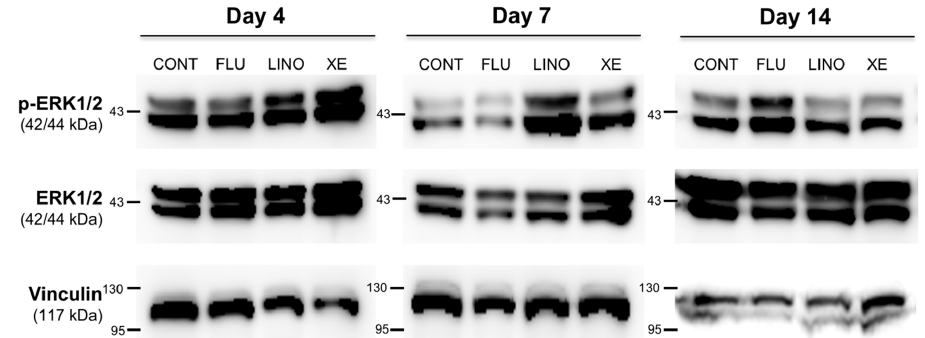
Figure 9. Alterations of ERK1/2 phosphorylation by the K V 7 opener or K V 7.3 blockers in MG-63 cells. Western blot analysis showed that, while linopirdine (30 µ M) and XE991 (10 µ M) increased the expression level of ERK1/2 phosphorylation at days 4 and 7 of osteoblast induction, flupirtine (30 µ